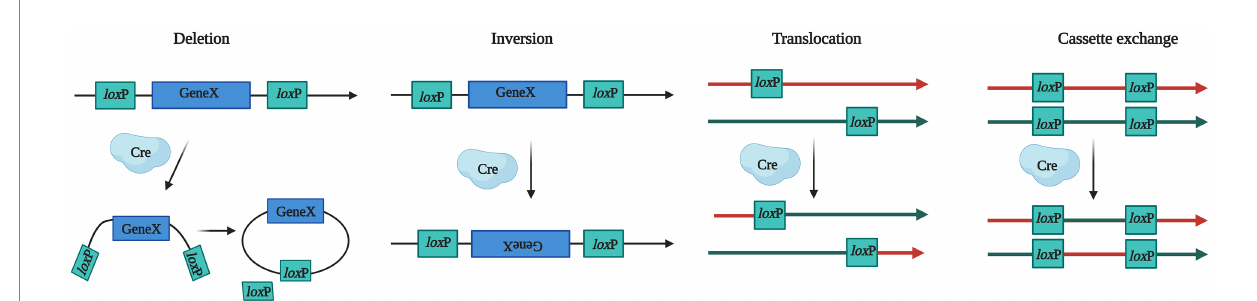
FIGURE 2 Biological mechanisms for Cre– lox P system. Cre recombinase can recognize the lox P site and promote gene recombination. Lox P is a unique gene sequence from the P1 phage, which guides the Cre to target sites of the genome. Gene X stands for target gene. The Cre– lox P system can produce four types of gene modification, including deletion, inversion, translocation, and cassette